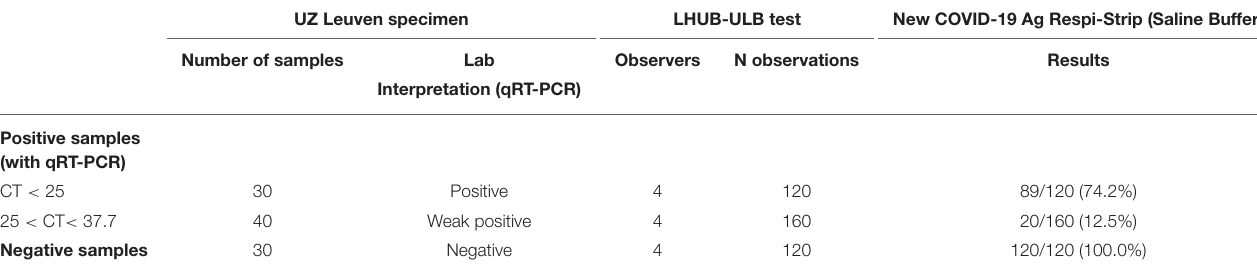
TABLE 1 | Analytical performance study.